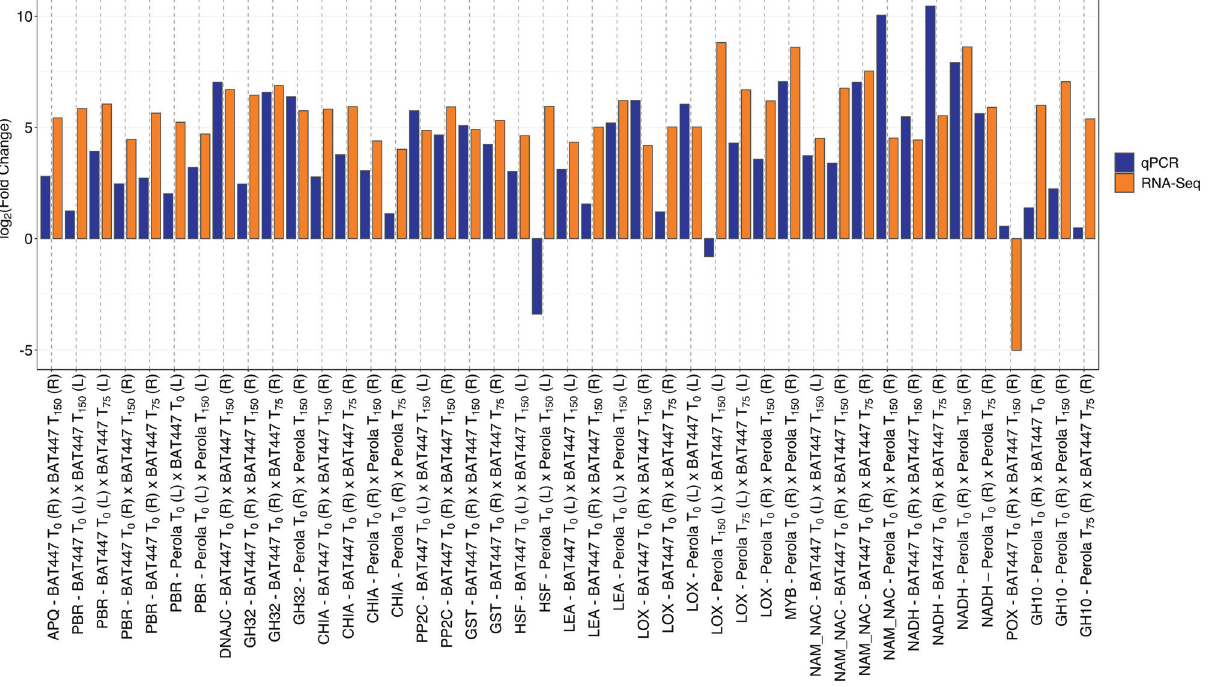
Figure3 -ComparisonsbetweenthegeneexpressionprofilesobtainedforDEGsbyRNA-SeqandqPCRanalyses.Amongthe15geneschosentobevali- date by qPCR, those genes differentially expressed in RNA-Seq had their values of cycle quantification (Cq) expressed as a fold-change and then com- pared between the